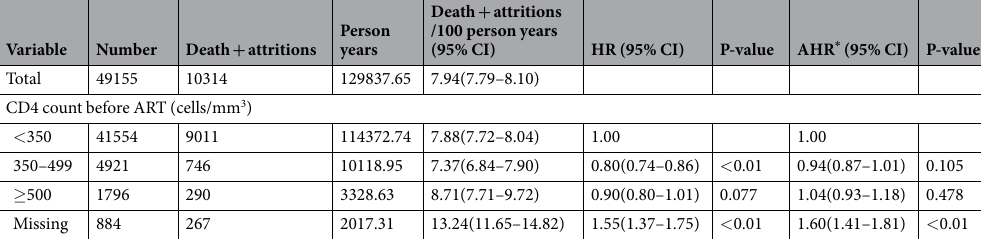
Table 7. Effects of CD4 count before ART on Death + attritions in HIV-infected patients who started ART between 2010 and 2015 in Guangxi, China. * HR = hazard ratio; AHR = adjusted hazard ratio; covariates of the adjusted model included: age, sex, marital status, route of HIV infection, WHO clinic stage before ART, initial ART regimen, year initiated